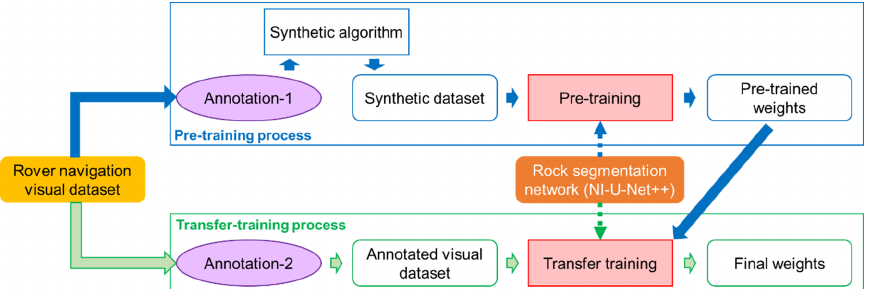
Figure 1. The pipeline of the proposed rock segmentation framework. The rover navigation visual dataset used in this research is the Katwijk beach planetary rover dataset [49], while it can be different in other scenarios. The synthetic dataset for the pre-training is not augmented, while the annotated visual dataset for the transfer training is applied augmentation to extend the dataset.